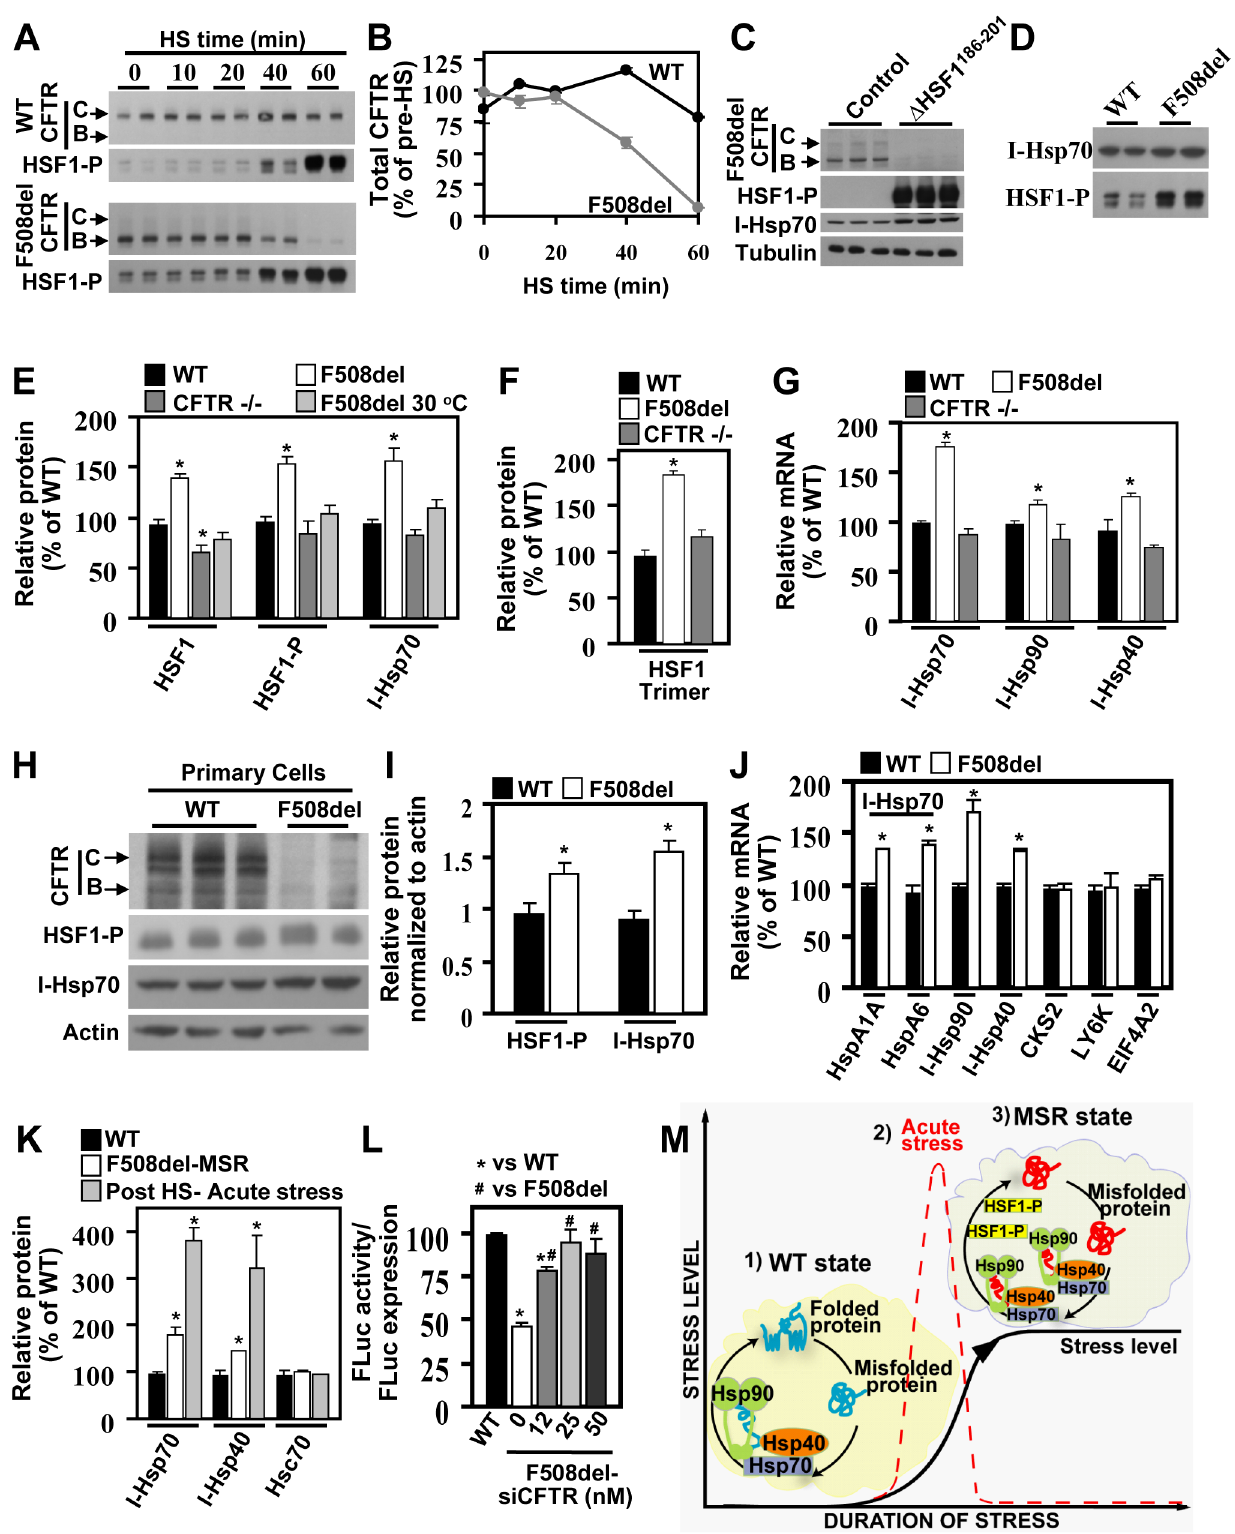
Figure 1. Expression of F508del induces chronic proteotoxic stress that affects cellular protein folding. (A) Immunoblots of WT-CFTR, F508del-CFTR, and HSF1-P during HS time course (42 u C for a total of 60 min). (B) Quantification of total CFTR during HS, relative to pre-HS (T=0) ( n =4). (C) Immunoblots of indicated proteins in CFBE41o- cellular lysates following the co-expression of F508del-CFTR with the constitutively active D HSF1 186–201 or control empty plasmid. (D) Immunoblots of HSF1-P and I-Hsp70 in WT or F508del expressing cells ( n =4). (E) Quantification of the expression of HSR markers in WT-CFTR, F508del-CFTR at 37 u C or 30 u C, and CFTR null (CFTR 2 / 2 ) expressing cells. (F) Quantification of HFS-1 trimer